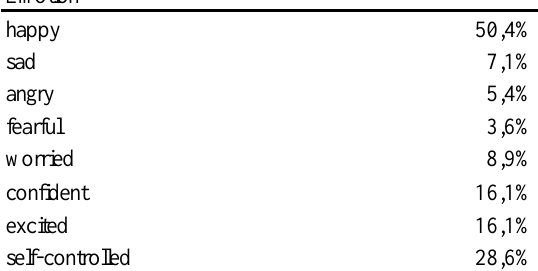
Table 1: Self Reported Emotional State Emotion